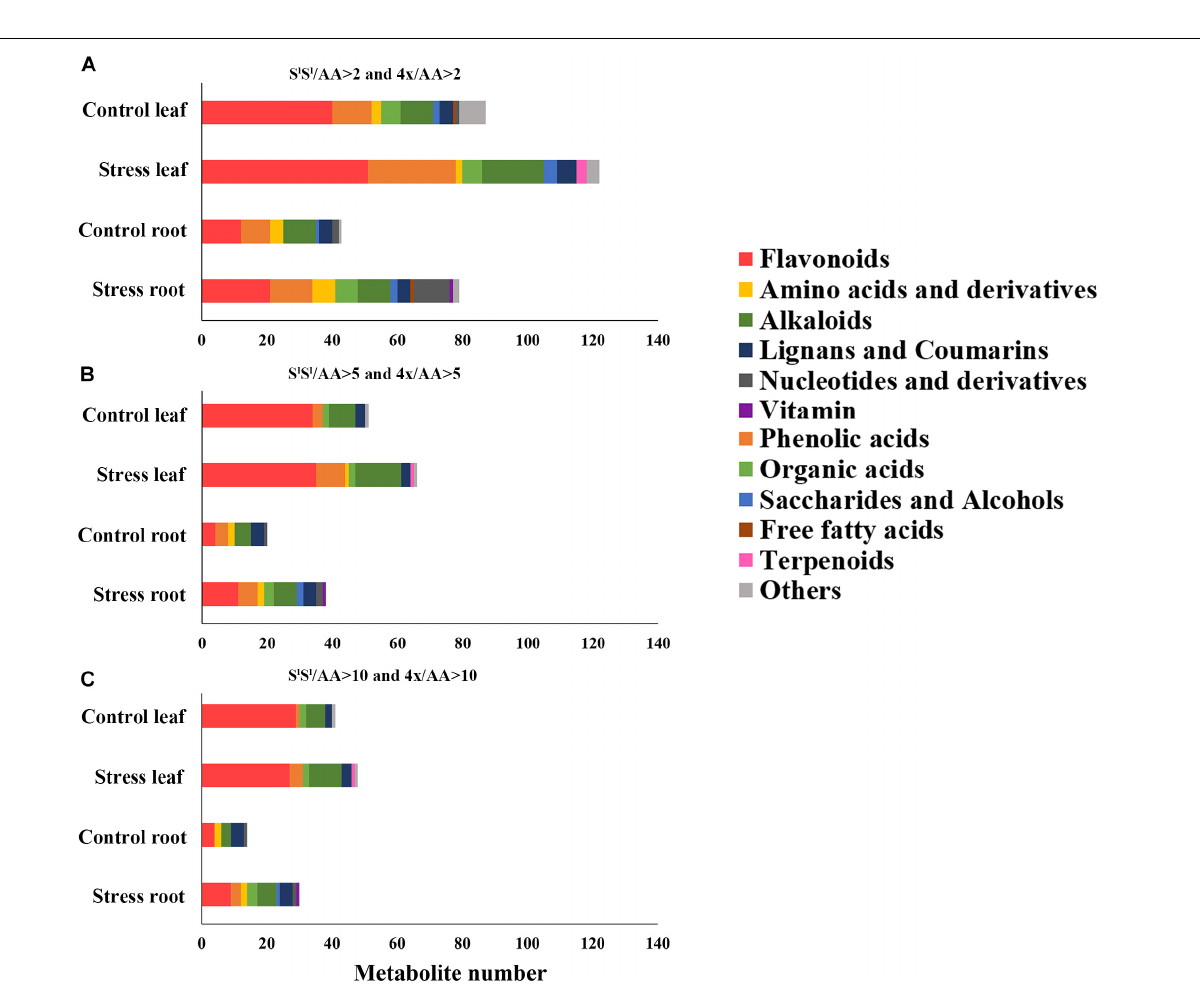
FIGURE 8 | Comparison among three wheat lines in metabolite level for different types of metabolites. The metabolite was counted if its level in AA plants was lower than that in either of 4x and S l S l plants. (A) The metabolite level in AA plants was lower twofolds than that in either of 4x and S l S l plants (4x/AA > 2 VIP > 1 and S l S l /AA > 2 VIP > 1), (B) the metabolite level in AA plants was lower fivefolds than that in either of 4x and S l S l plants (4x/AA > 5 VIP > 1 and S l S l /AA > 5 VIP > 1), and (C) the metabolite level in AA plants was lower 10-folds than that in either of 4x and S l S l plants (4x/AA > 10 VIP > 1 and S l S l /AA > 10 VIP > 1). The seedlings were exposed to 150 mM NaCl for 7